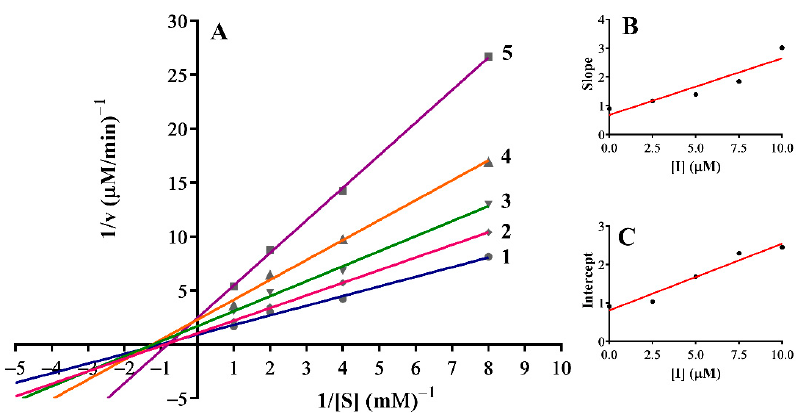
Figure 2. ( A ) Lineweaver − Burk plots for the inhibition of 5 on the mushroom tyrosinase for the catalysis of DOPA at 28 °C, pH 6.8. Concentrations of 5 for curves 1–5 were 0.0, 2.5, 5.0, 7.5 and 10.0 µ M, respectively. The insets ( B , C ) represent the secondary plot of the slopes and intercepts versus concentrations of 5 to determine the inhibition constants.